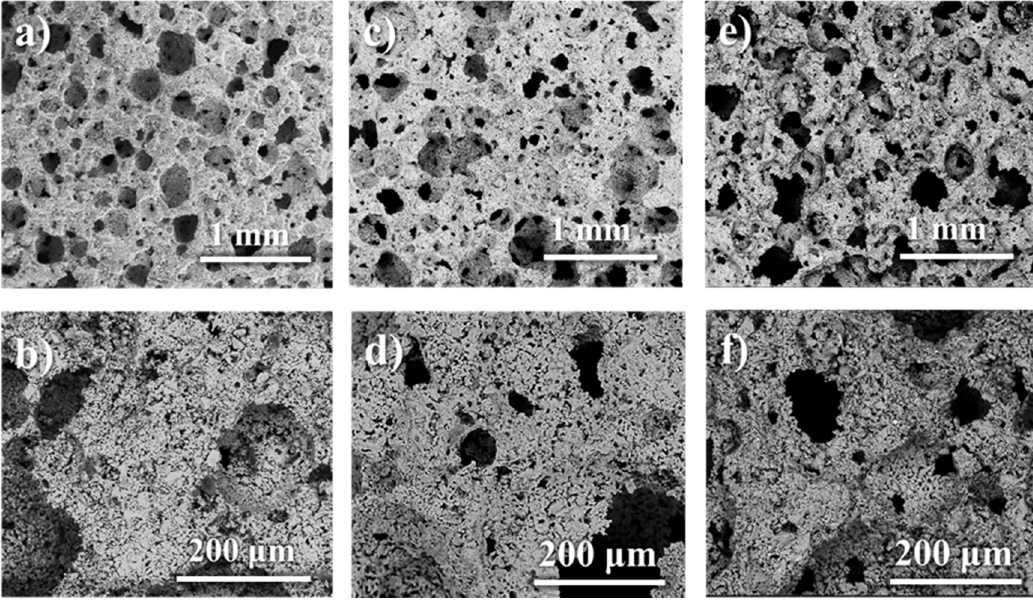
Figure 6. SEM pictures of VBA–SLG foams fired at 900 °C: ( a , b ), 950 °C ( c , d ), and 1000 °C ( e , f ).